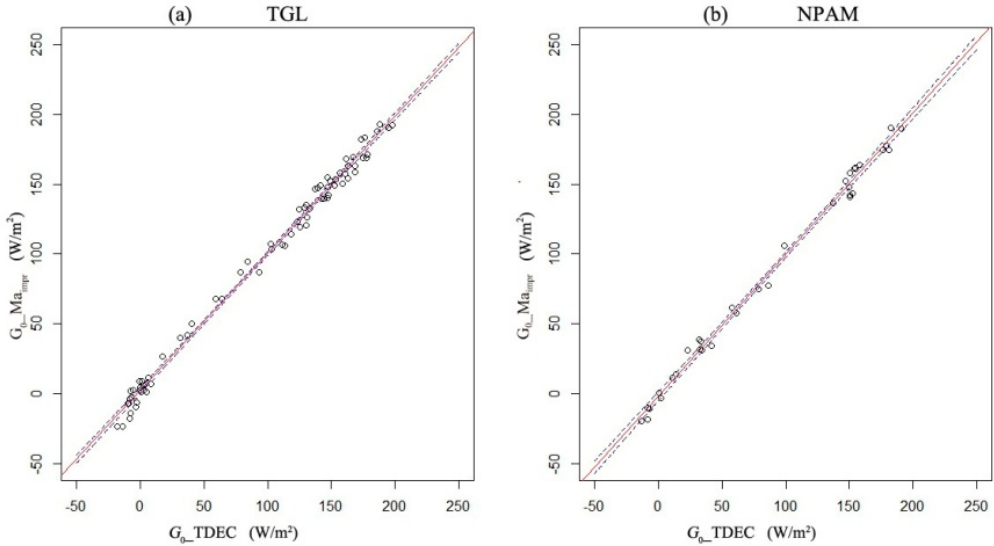
Figure 8. The linear relationship between the land surface soil heat flux G 0 calculated by the TDEC method (G 0 _TDEC) and the parameterization scheme Ma impr (G 0 _Ma impr ) using measured data from the TGL and NPAM sites (the red line represents a straight line with a slope of 1 and an intercept of 0). The blue line represents the 95% confidence interval line. Land surface temperature T s is obtained by Equation (2) using observed long wave